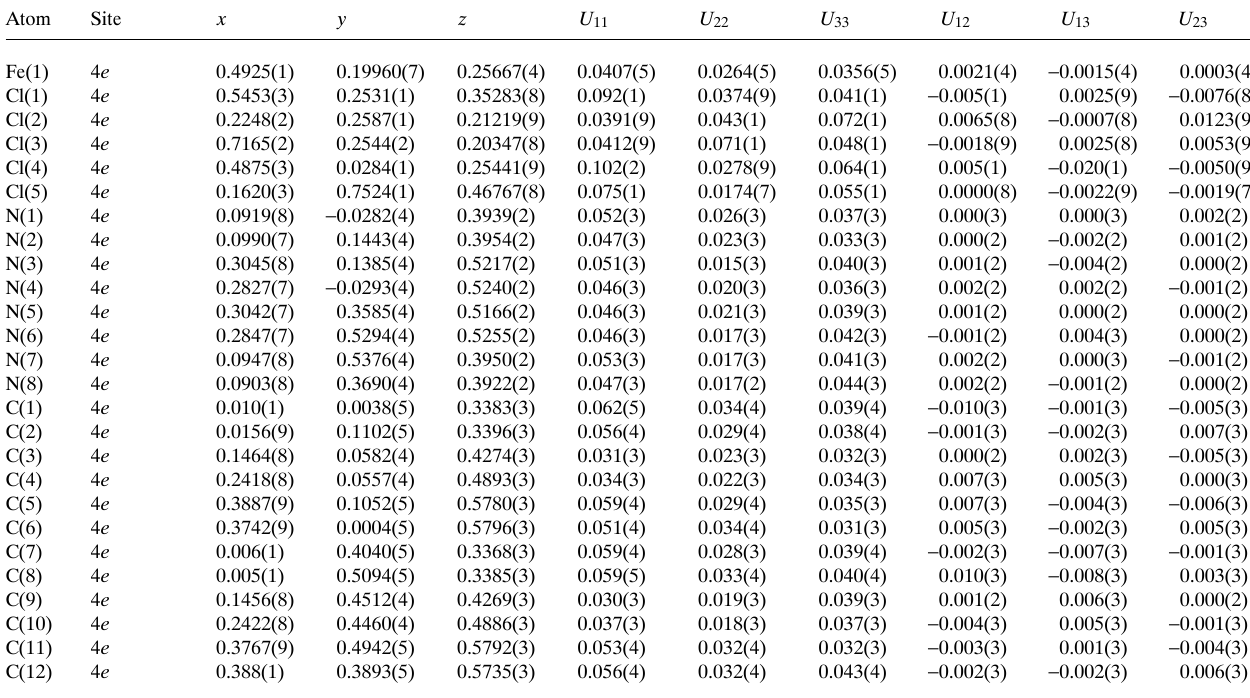
Table 3. A tomic coordin a tes a nd displ a cement p a r a meters (in Å 2 ) .